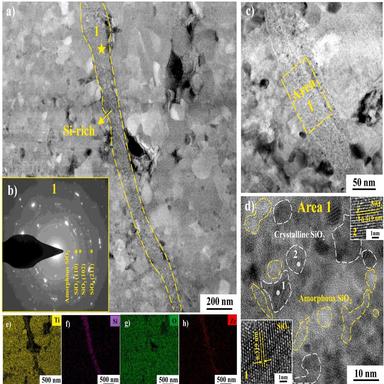
Microstructure of SiO2 with semi-amorphous and semi-nanocrystalline structure: (a) TEM-BF image of SiO2, (b) diffraction patterns of the "yellow star" marker in (a), (c) high magnification TEM-BF image of (a), (d) HRTEM image of "Area 1′′ marked in (c) with high magnification image inserted, (e–h) STEM-EDS elemental mappings of Ti, Si, O, Zr across the (a). (For interpretation of the references to color in this figure legend, the reader is referred to the web version of this article.)